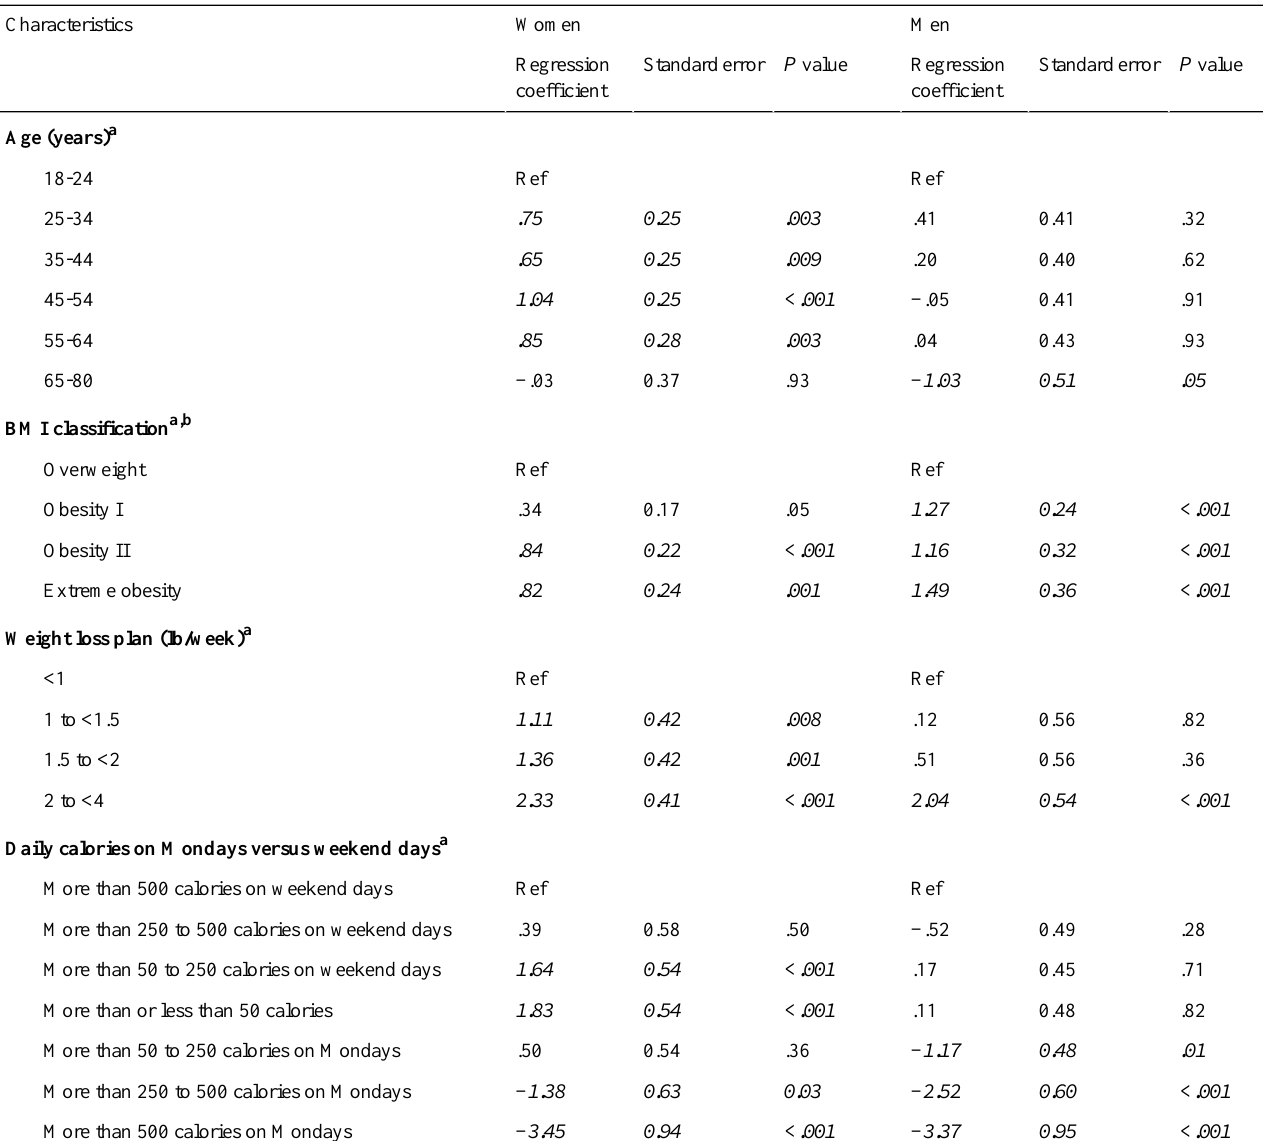
Table 2. Unadjusted linear regressions of percentage of bodyweight lost among women and men who used the Lose It! mobile app (sex-specific intercepts for models are not reported; N=7007). Estimates in italics are significant at P <.05. BMI: body mass index. Ref: reference category.